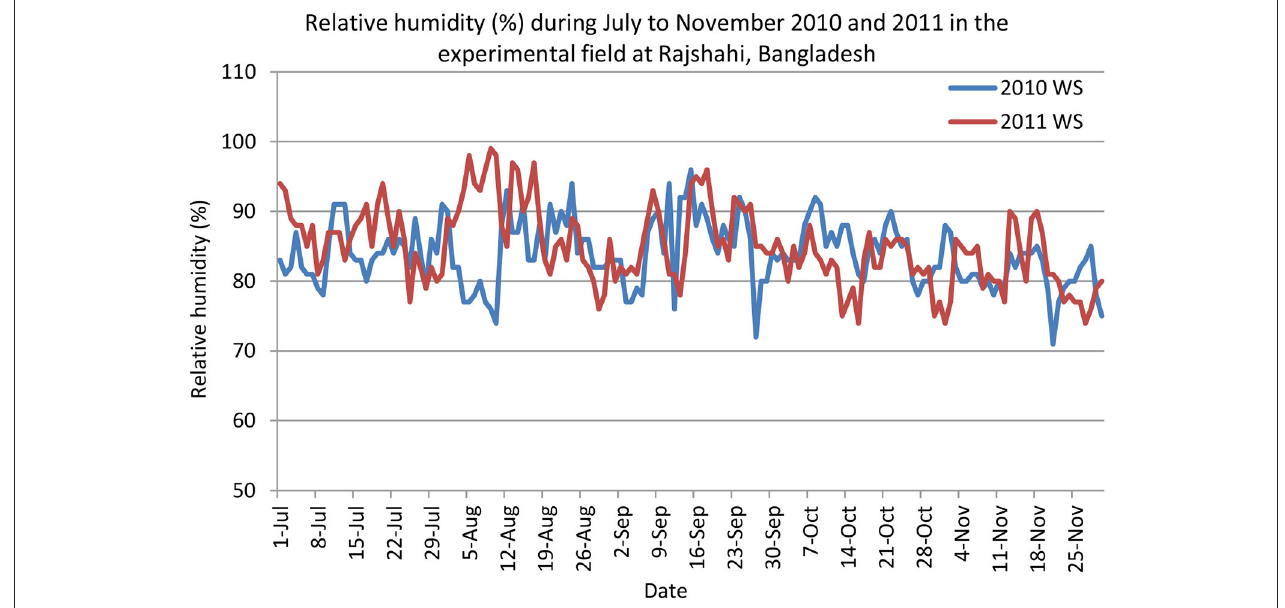
mean daily sunshine duration was 6.14 and 5.65 h in 2010